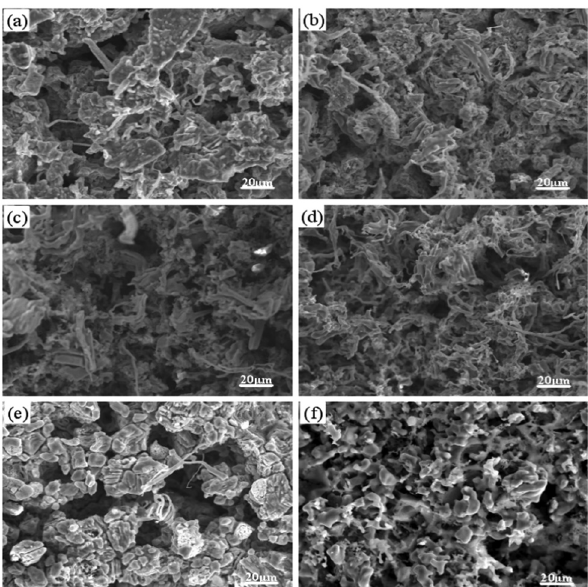
Figure 6: Mineralogical microstructure photographs of roasted bri - quette specimens at di ff erent basicity values ( H, hematite phase; S, silicate slag phase; P, porosity ) . ( a ) – ( f ) Briquette specimens #1 ( 0.2 ) , #2 ( 0.4 ) , #3 ( 0.6 ) , #4 ( 0.8 ) , #5 ( 1.0 ) , and #6 ( 1.2 ) .